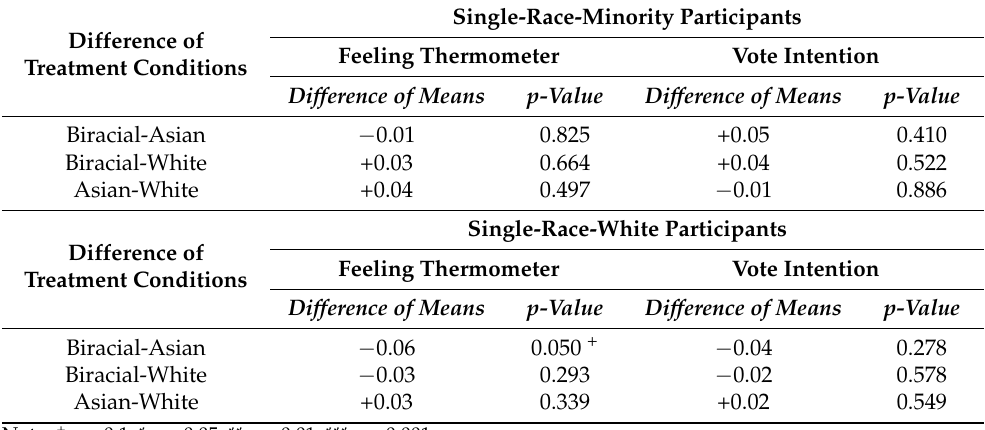
Figure 5. Mean feeling thermometer and vote intention ratings of hypothetical candidates from the Asian and White heritage treatment conditions. Sample includes only single-race participants who indicated having two parents who share the same race (i.e., either two White parents or two single-race-identified minority parents). X -axis denotes different treatment groups based on the identity cued by our hypothetical candidates. Note: error bars denote 95% confidence intervals. Table 5. Results from difference-of-means t -tests for all possible treatment group comparisons in Figure 5.